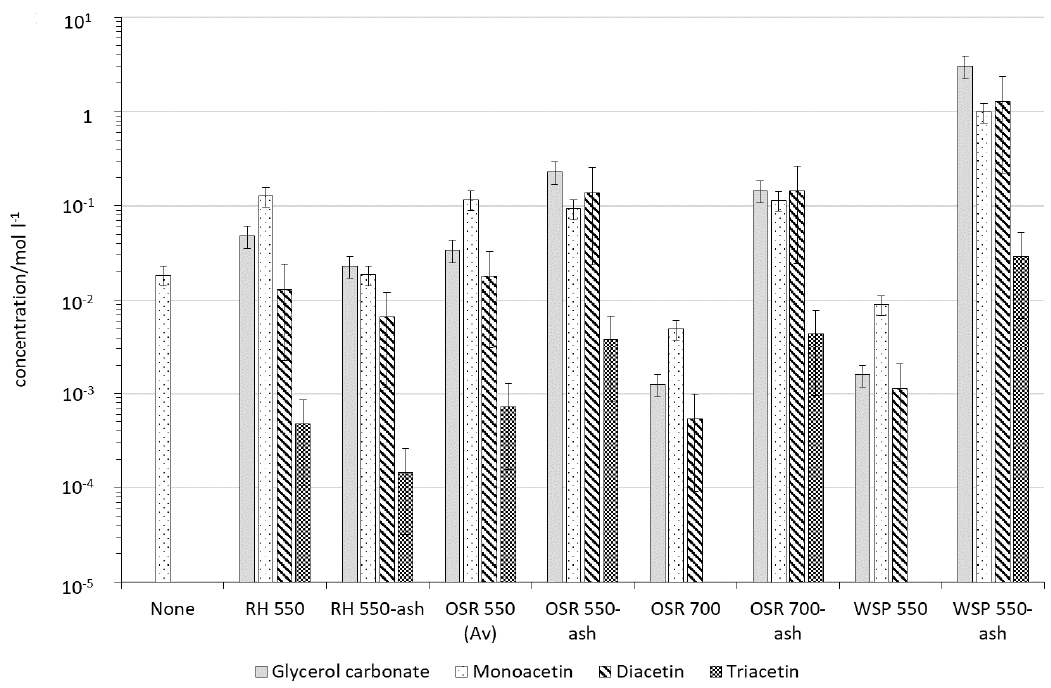
Figure 7. Comparison of production of glycerol carbonate and acetins from biochar and biochar ash from different feedstocks (rice husk (RH), oil seed rape (OSR) and wheat straw (WSP)). (Av) indicates an average of three readings; this was used to estimate the percentage error. A logarithmic y -axis is used to present high and low concentration products.